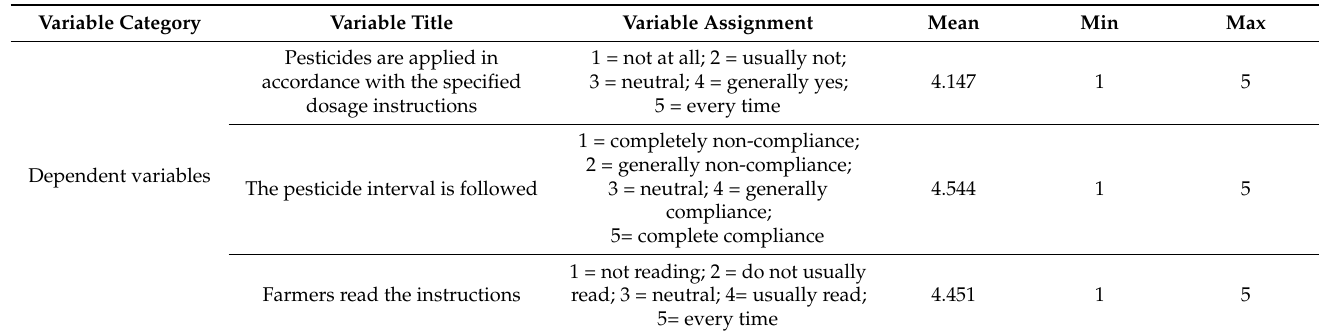
Table 2. Model variable assignment and the descriptive